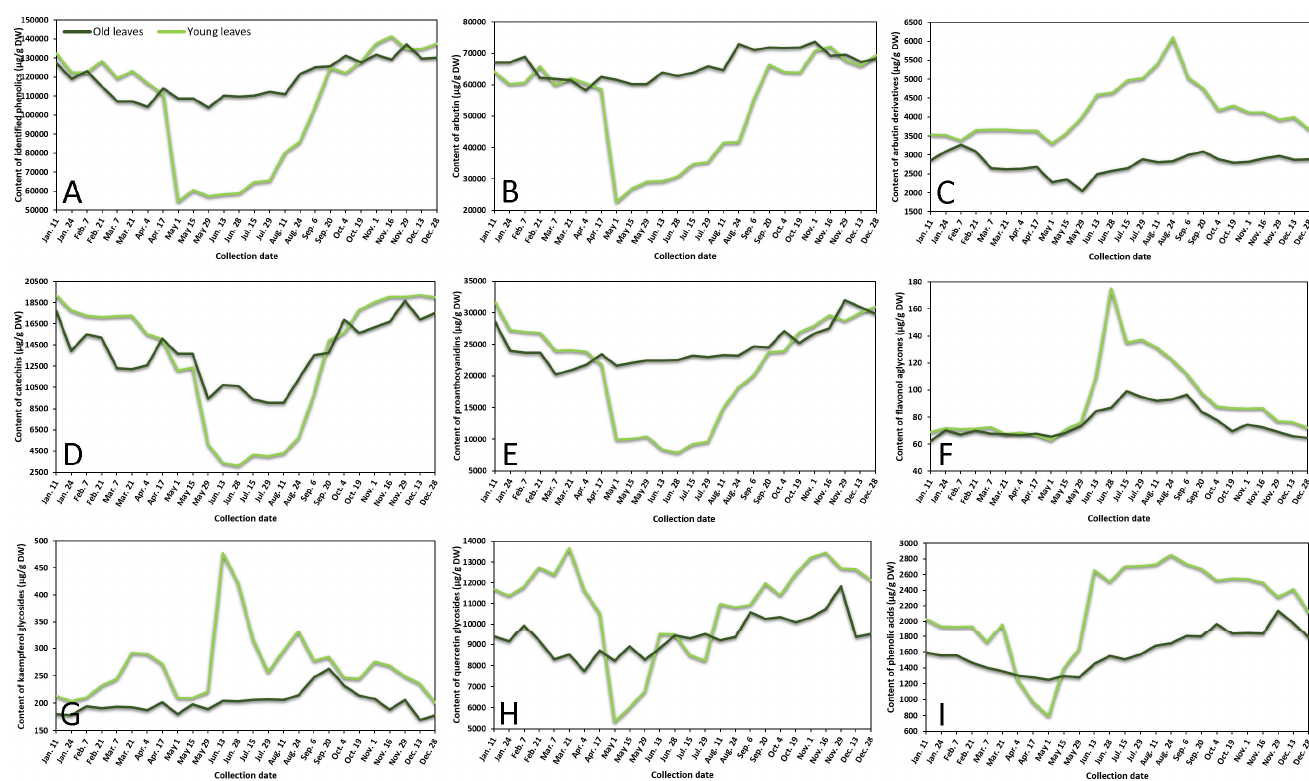
Figure 1. Variation in sums of ( A ) all identified phenolics, ( B ) arbutin, ( C ) arbutin derivatives, ( D ) catechins, ( E ) proanthocyanidins, ( F ) flavonol aglycones, ( G ) kaempferol glycosides, ( H ) quercetin glycosides, and ( I ) phenolic acids ( µ g/g DW) in young (light line) and old (dark line) lingonberry leaves during one year testing period. Abbreviations of months have been defined in Appendix A.